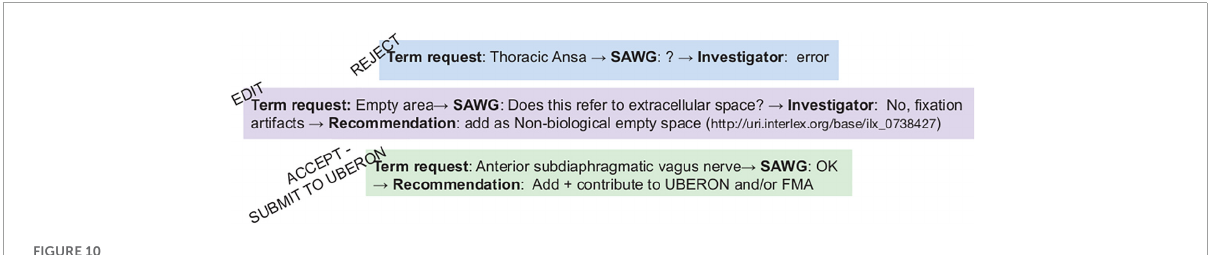
FIGURE10 SAWG term review. Examples of the SAWG review process. e.g., The Thoracic ansa was submitted to the pipeline and reviewed by the SAWG since the SAWG did not recognize the term after additional investigation. Once contacted, the investigator indicated it was an